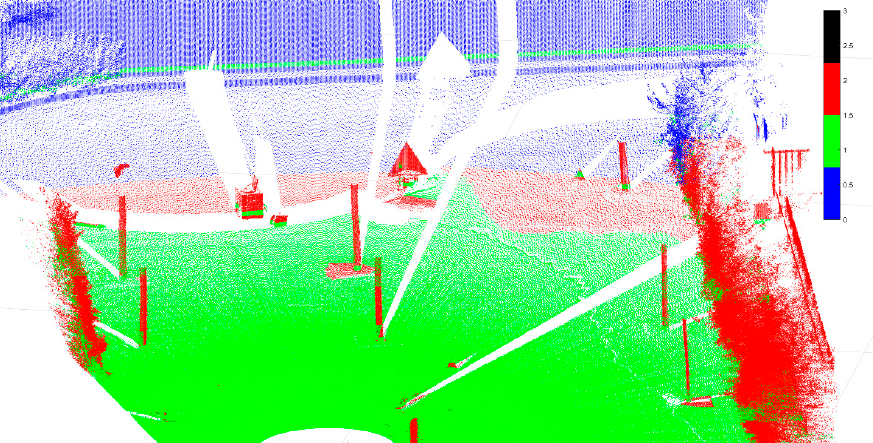
Figure 18. Preliminary results of automatic classification of DSM point cloud, the target is to select the coherent points target in the red region, green represents the ground, and blue represents the unclassified object.